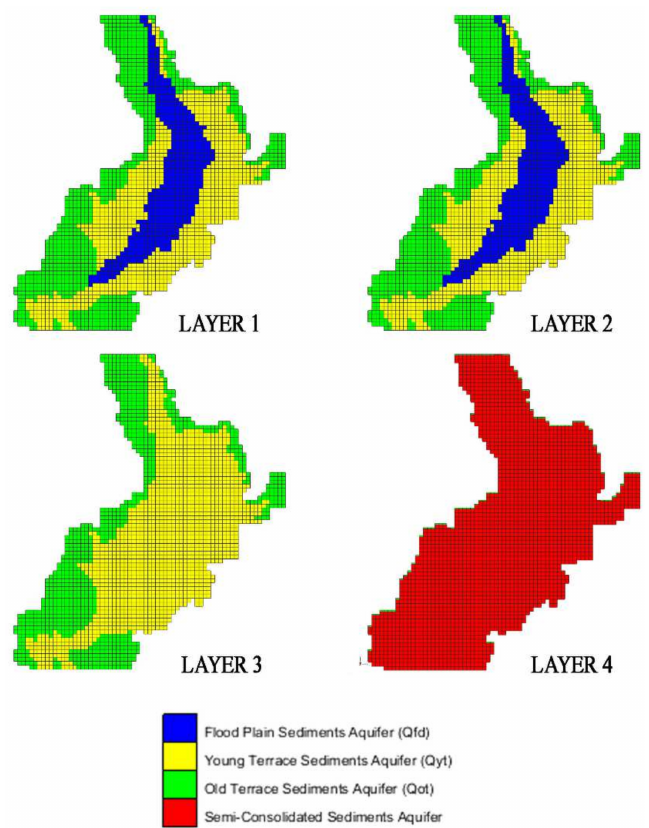
Figure 8. Distribution of aquifer units in four model layers.